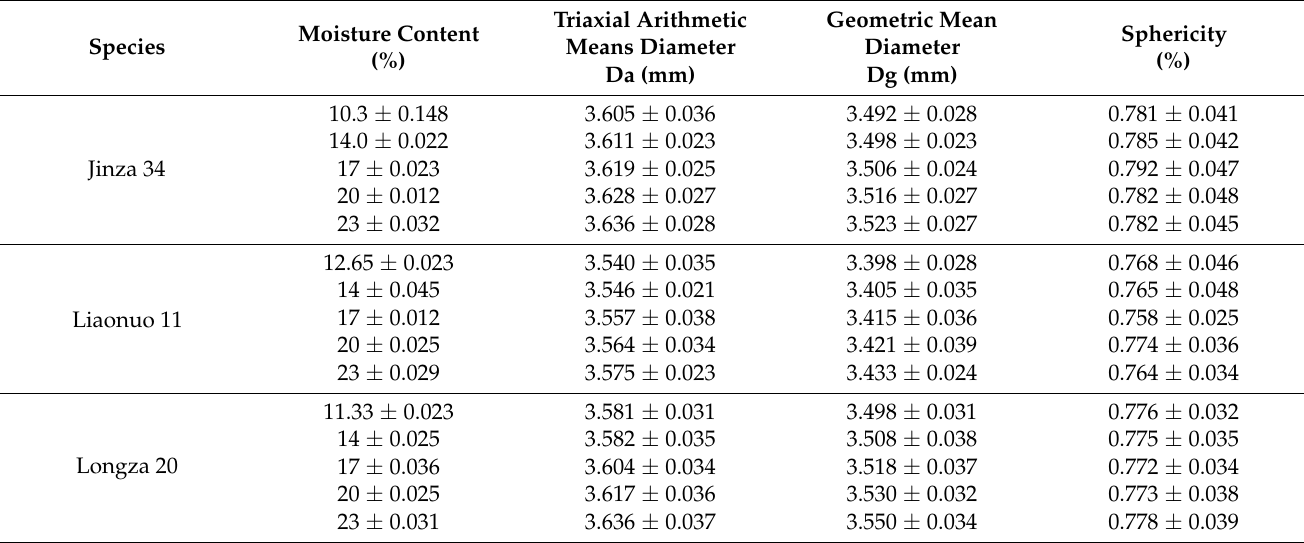
Table 1. Arithmetic means diameter, geometric mean diameter and sphericity of different varieties at different moisture contents.